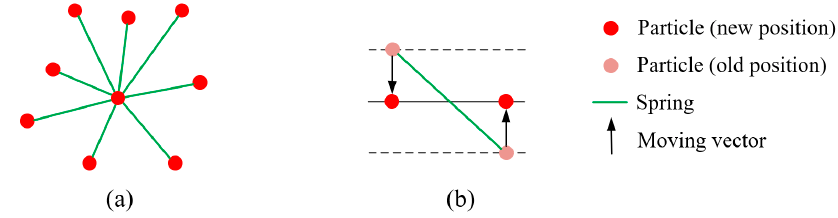
Figure 4. Schematic illustration of ( a ) cloth model and ( b ) cloth simulation.